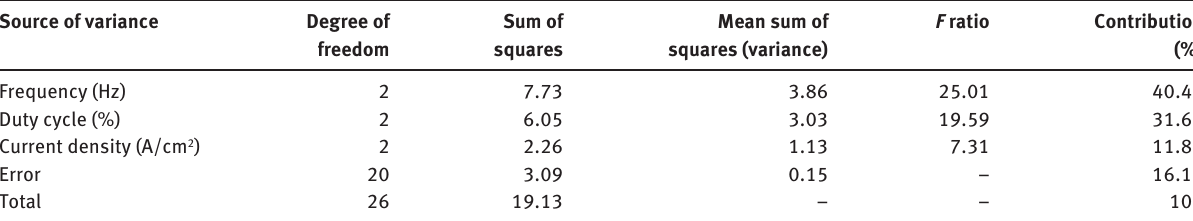
and peak current density 0.6 A/cm 2